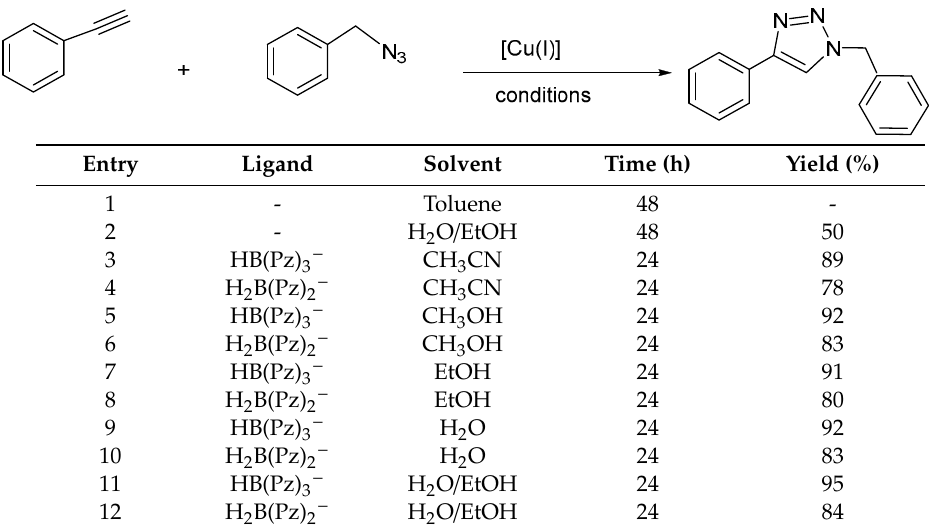
Table 2. Conditions screening for the [3+2] cycloaddition (32CA) reaction of benzyl azide and Conditions screening for the [3 + 2] cycloaddition (32CA) reaction of benzyl azide and phenylacetylene.